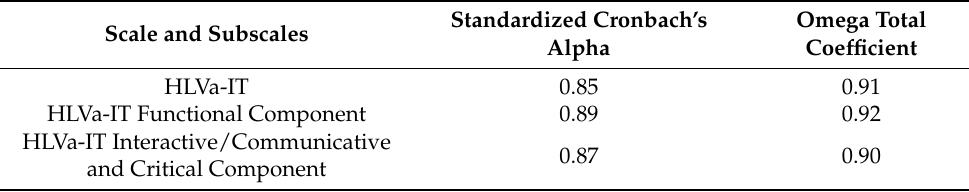
Table 3. Internal consistency: standardized Cronbach’s alpha and Omega total